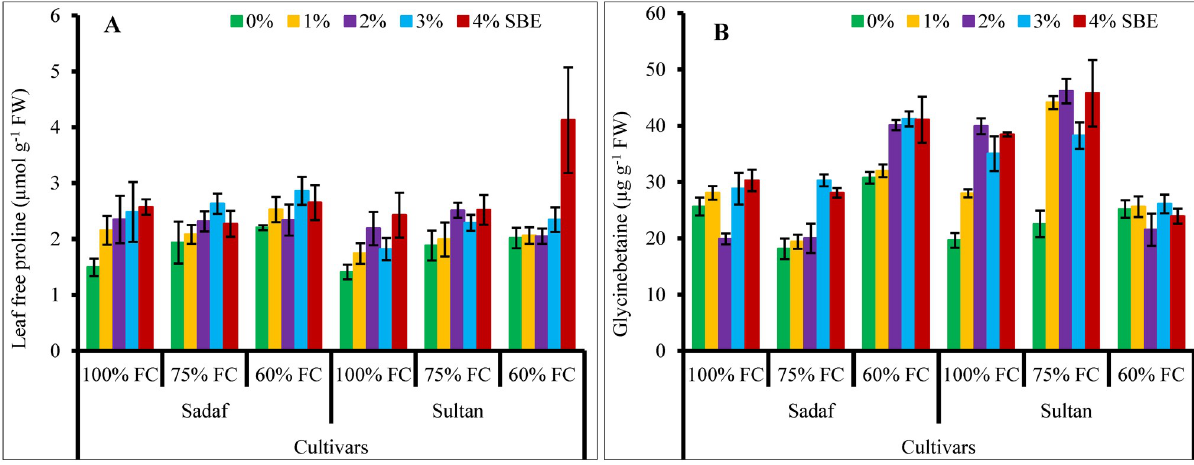
Fig 4. Application of SBE enhanced (A) leaf free proline and (B) glycinebetaine contents (GB) of maize plants subjected to water-deficit stress ( n = 3; Mean ± S.E.).